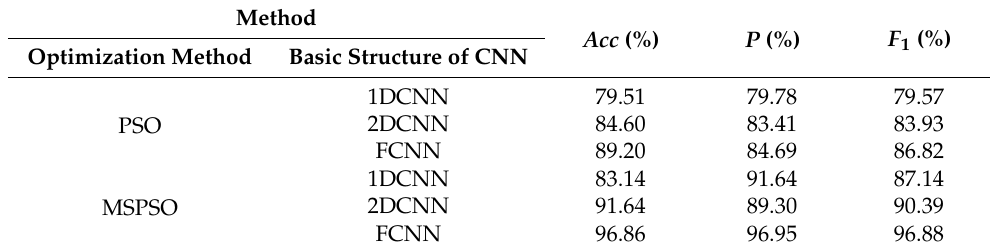
Table 6. Diagnosis results of different models.